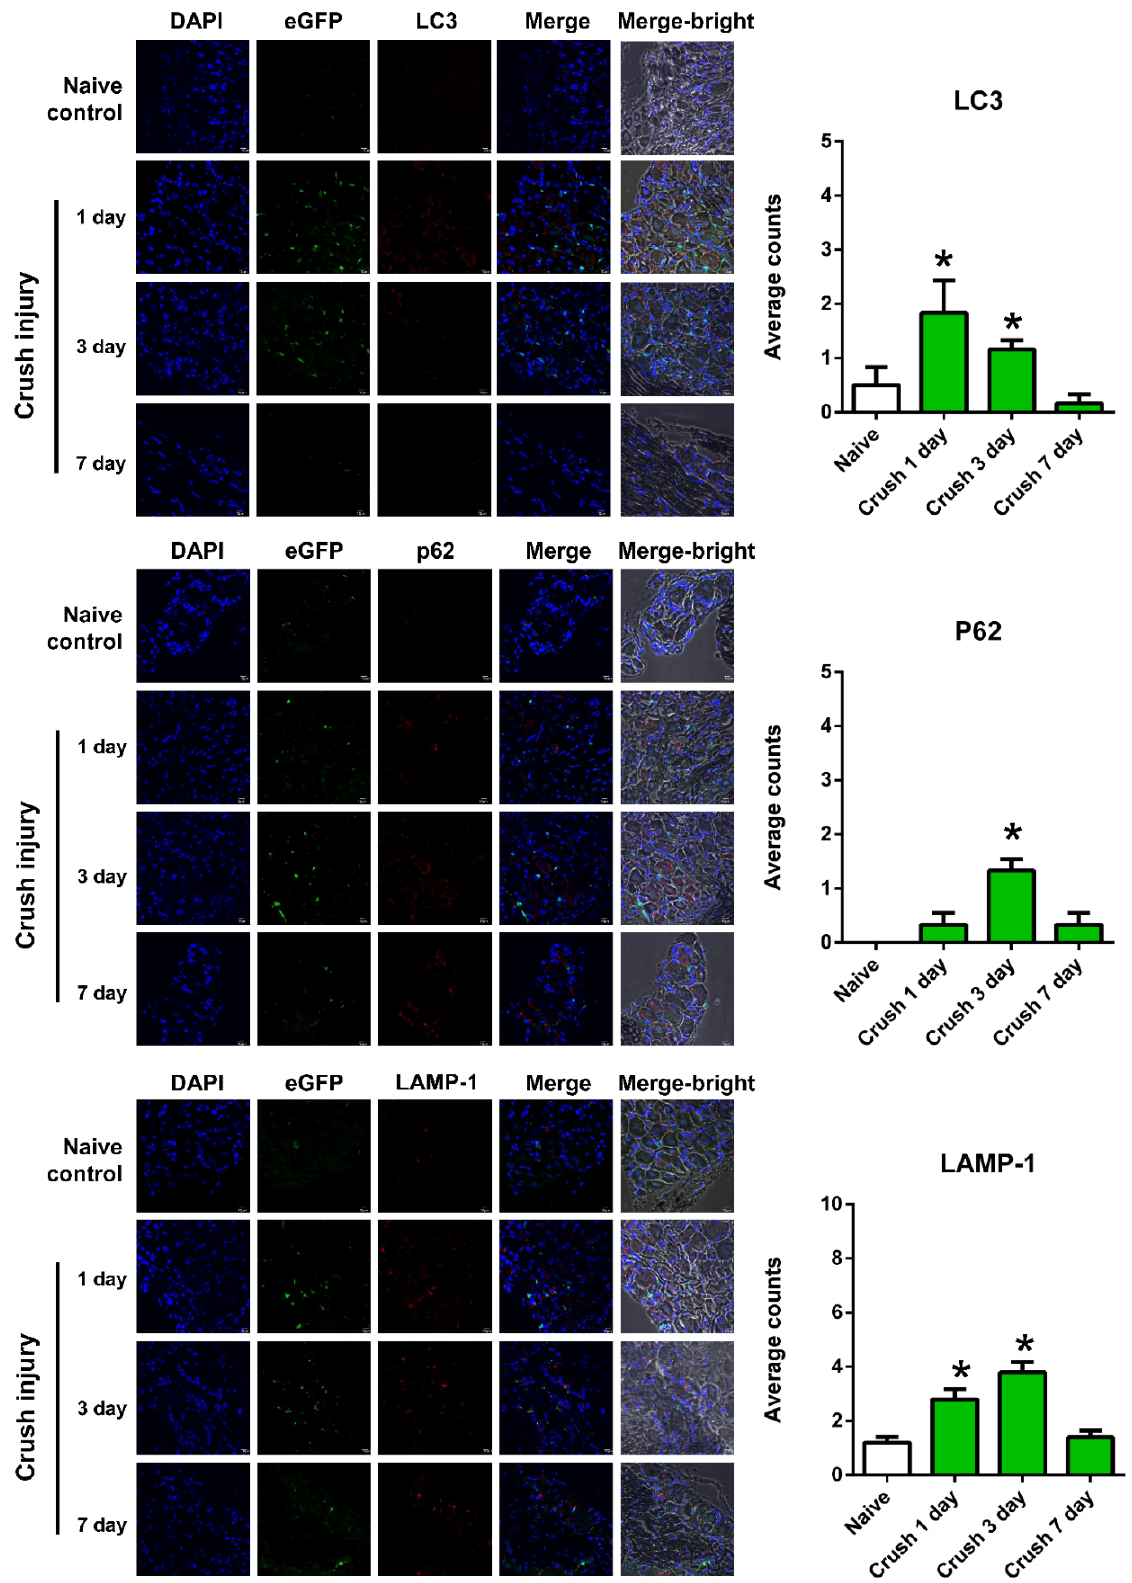
Figure 2. Immnuohistochemistry depicting the co-localization of DAPI and eGFP with autophagy-related markers (LC3, p62, or LAMP-1) in the dorsal root ganglia of L4–6 in the MaFIA mice without nerve crush injury (naïve control) and at 1 d, 3 d, and 7 d following sciatic nerve crush injury. * Indicates a significant change ( p < 0.05) when compared to those in the naïve control ( n = 6). The error bar represents the standard error of mean.